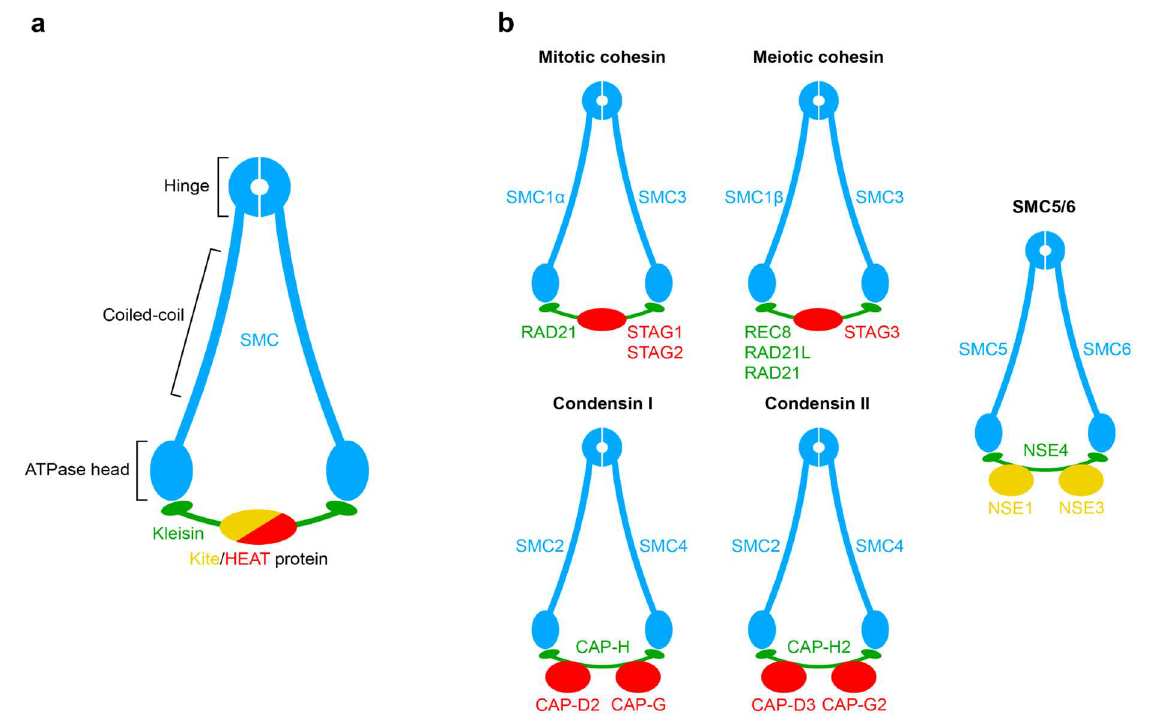
Figure 1. Basic structure of SMC complexes. ( a ) Main parts of SMC complex; ( b ) eukaryotic SMC– kleisin complexes (blue and green) with partner proteins (red and yellow).